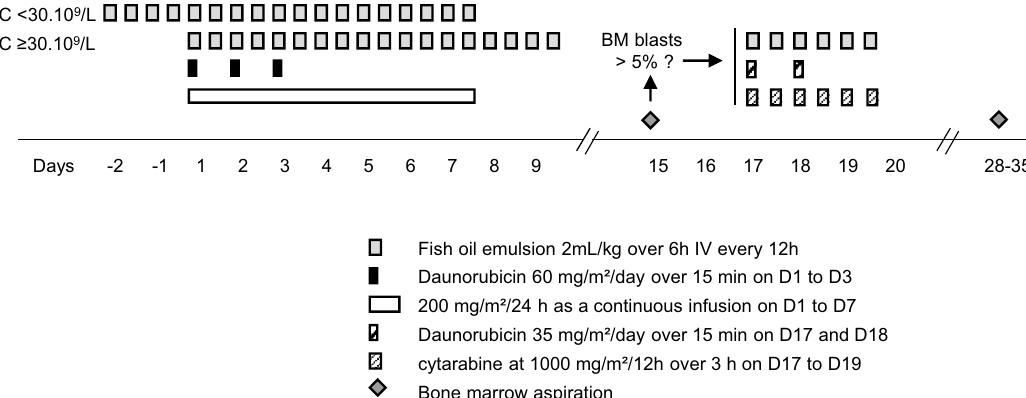
Figure 1. FAMYLY study design. Patients eligible for the study were treated with fish oil emulsion, daunorubicin and cytarabine at the indicated doses. If the baseline white blood count (WBC) was below 30 G/L, patients received 48 of fish oil before the start of chemotherapy. If the WBC was above or equal to 30 G/L, all treatments were started on the same day. An evaluation bone marrow (BM) evaluation was performed on D15. If the BM blasts were higher than 5%, a second induction was provided at the indicated